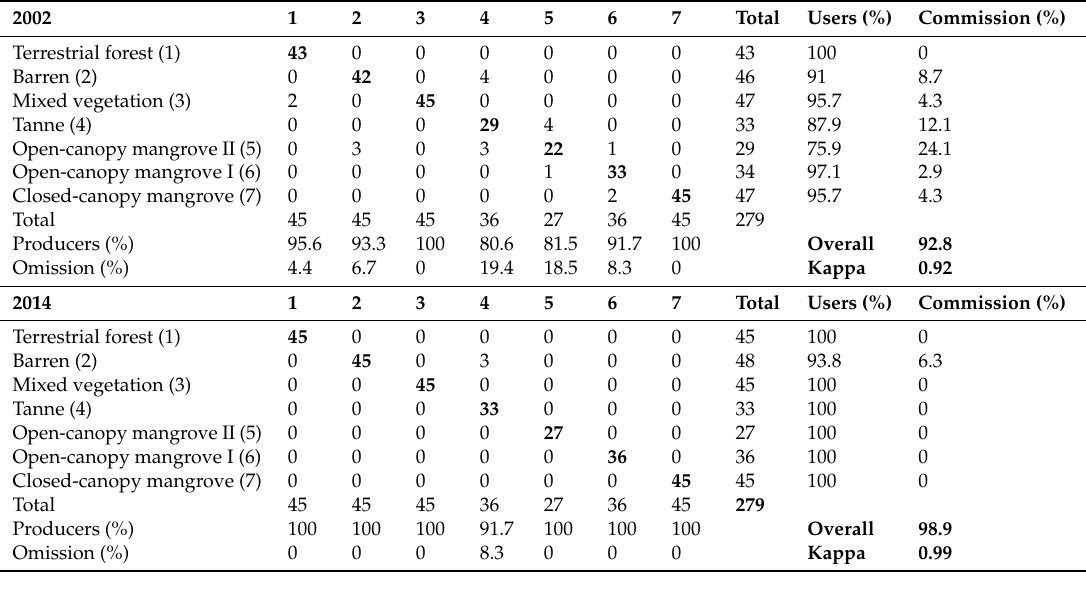
Table 6. Confusion matrices for the 2002 and 2014 Landsat classifications. Rows represent mapped classes and columns represent independent validation pixels.